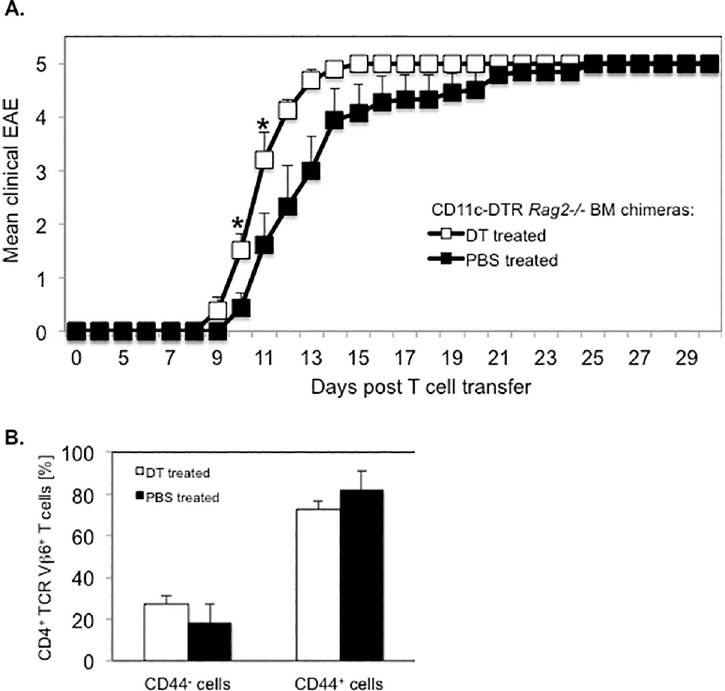
Fig 10. Transfer of PLP-specific CD4 + T cells induces severe EAE in long term DT treated CD11c-DTR Rag2 -/- SJL BM chimeras. CD11c-DTR Rag2 -/- SJL BM chimeric mice were treated with DT or PBS on consecutive days before and following the transfer of CD4 + T cells from na ï ve PLP TCR transgenic SJL mice for two weeks. Recipient mice were examined for clinical signs of EAE for 30 days. (A) Mean clinical EAE + SEM in DT treated (n = 8) or PBS treated (n = 9) recipient mice from two independent experiments is shown. (B) Spleen cells from DT treated (n = 5) or PBS treated (n = 3) mice affected with severe EAE (EAE score � 4) were analyzed for expression of the CD44 activation marker in transgenic T cells by flow cytometry. Frequencies of CD44 + (activated / memory) or CD44 - (non- activated) cells in transgenic (CD4 + TCR V β 6 + gated) T cells are shown as mean percentages ± SEM.